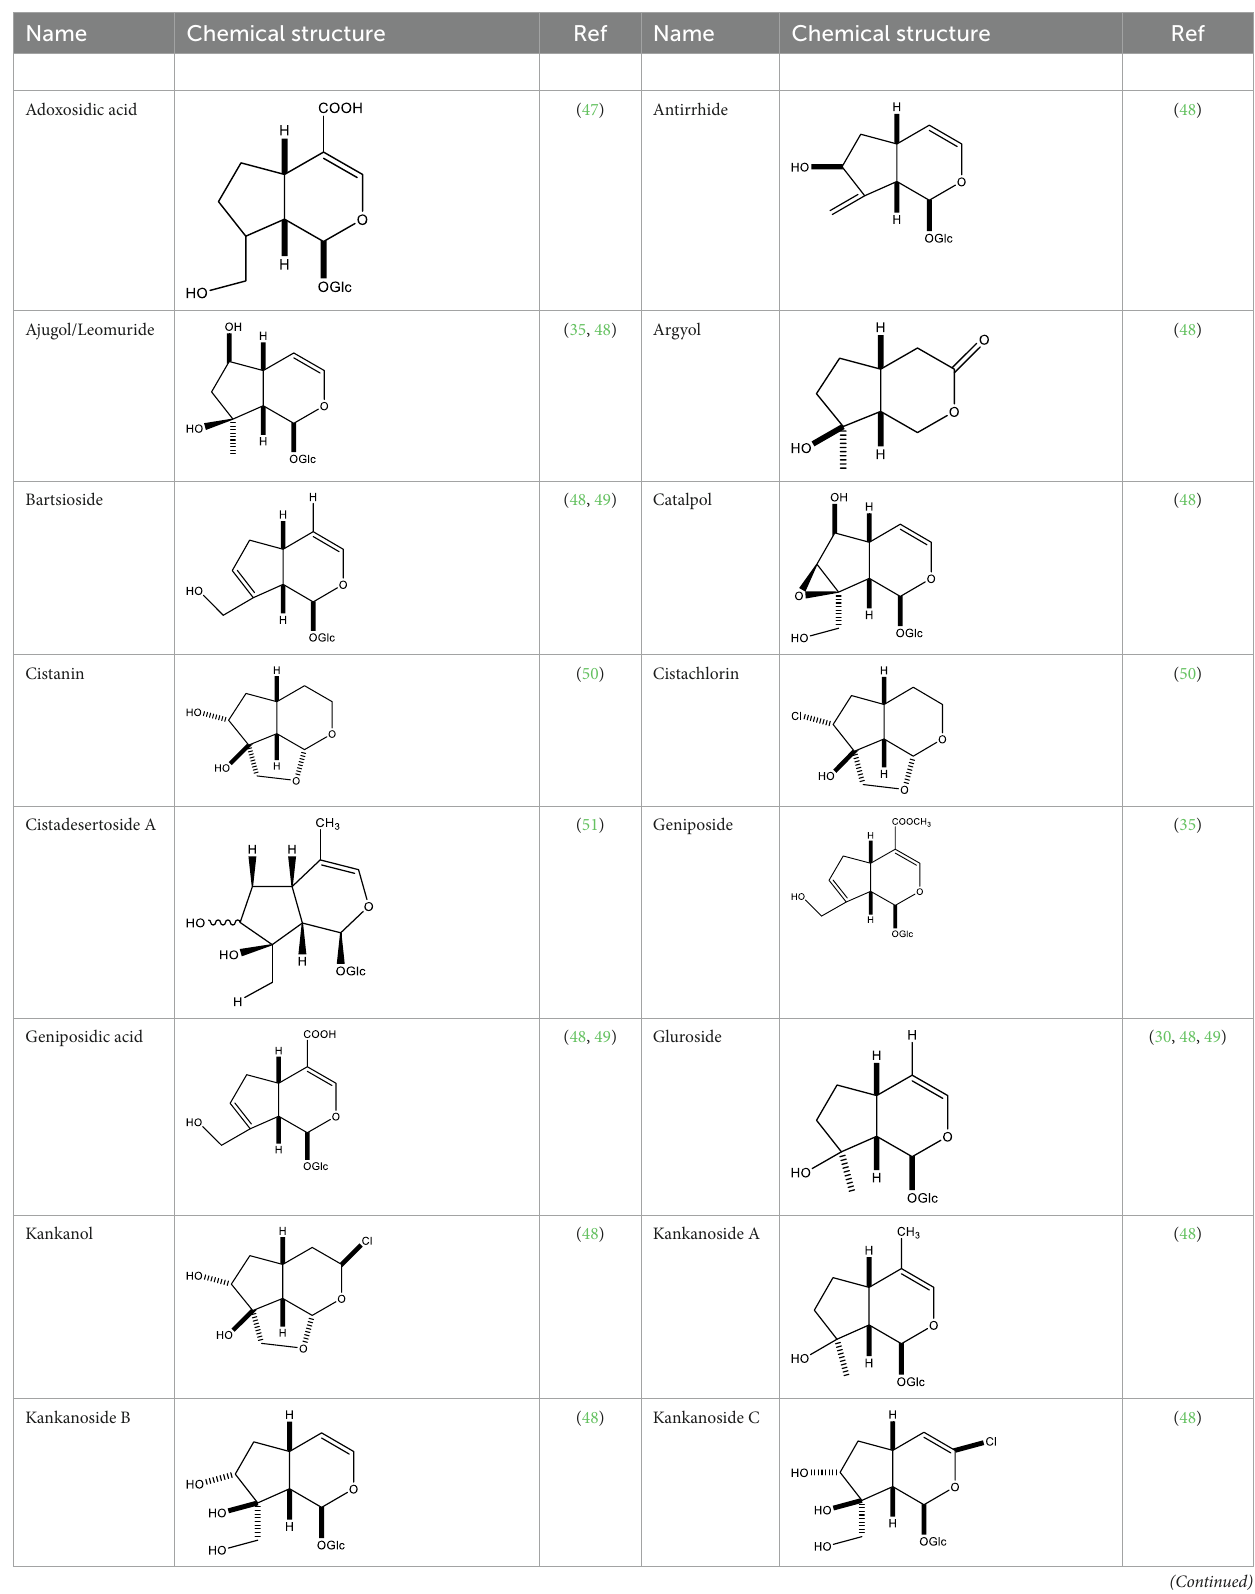
TABLE 3 Iridoids from Cistanche